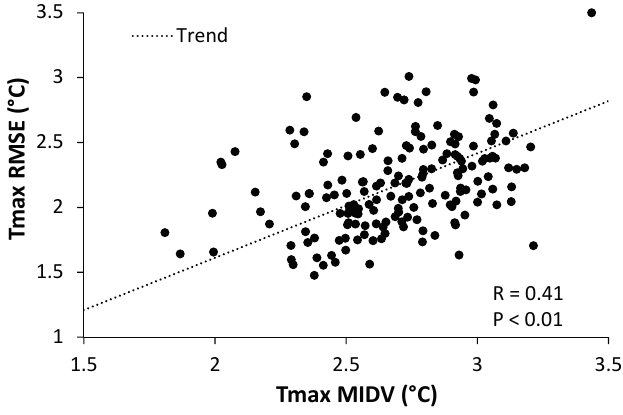
Figure 8. MIDV of ( a ) Tmax and ( b ) Tmin (°C) of the individual stations during 2008–2012 throughout the growing season.